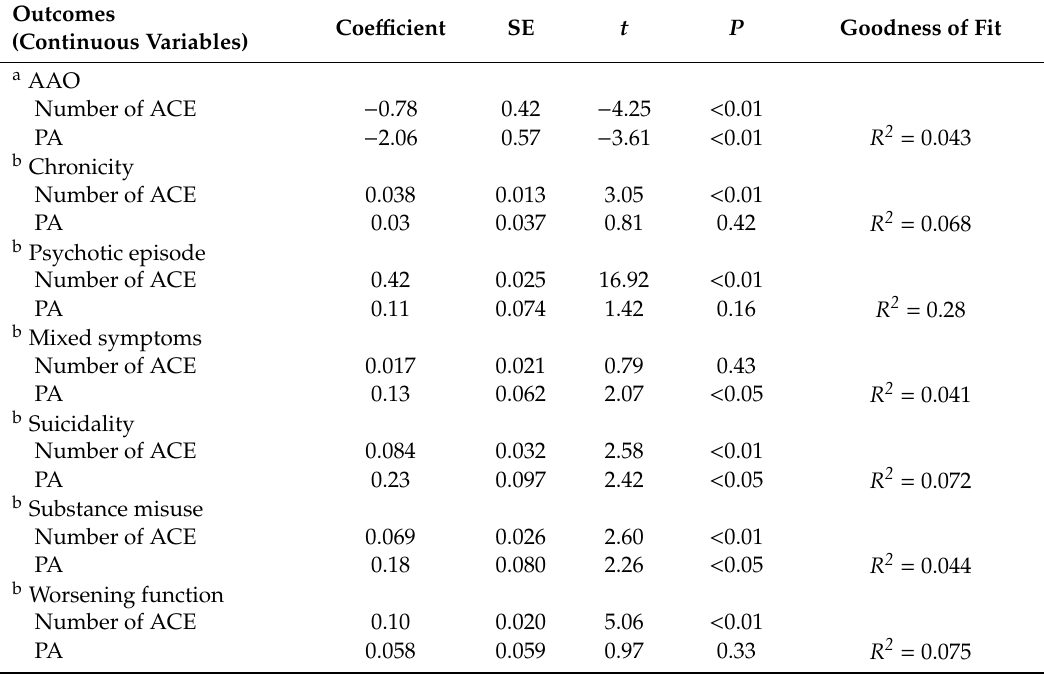
Table 8. Results of multiple linear regression analysis of clinical outcomes associated with adverse childhood experiences and physical abuse.